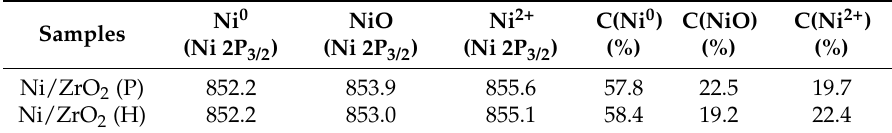
Table 3. Binding energy of Ni 2p lines and the corresponding surface concentration of Ni/ZrO 2 catalysts.